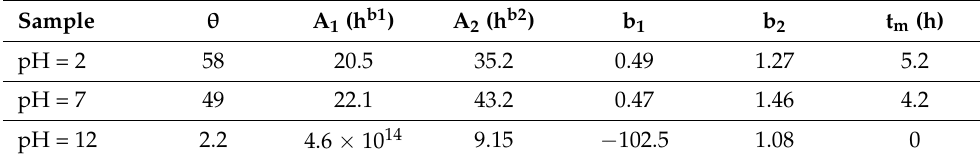
Table 3. Modified Weibull model’s